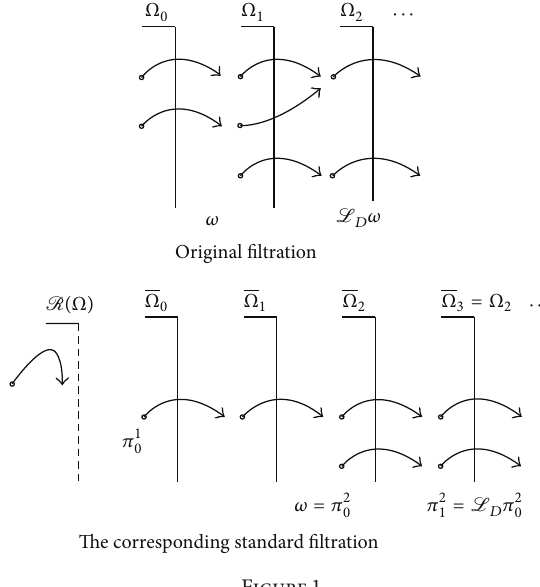
standard filtration Ω ∗ such that Ω ∗+𝑐 󸀠 = Ω ∗+𝑐 󸀠󸀠 for appropriate 𝑐 󸀠 , 𝑐 󸀠󸀠 ∈ N